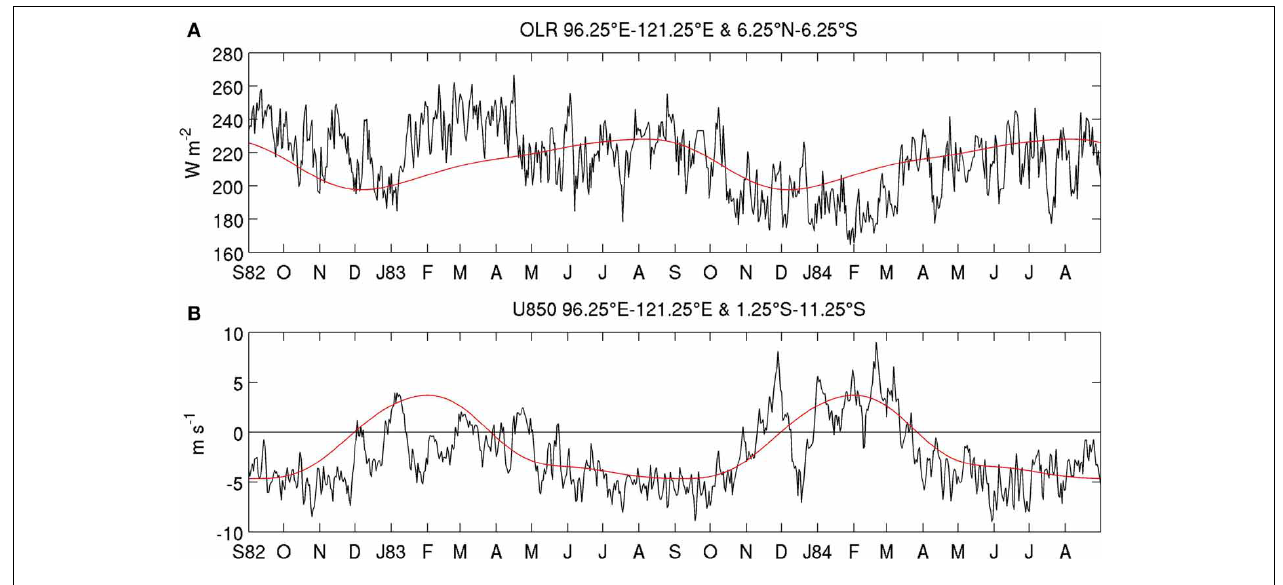
FIGURE 2 | Time evolution of the outgoing longwave radiation (OLR) and zonal winds. Plotted are the spatial average of (A) daily OLR on